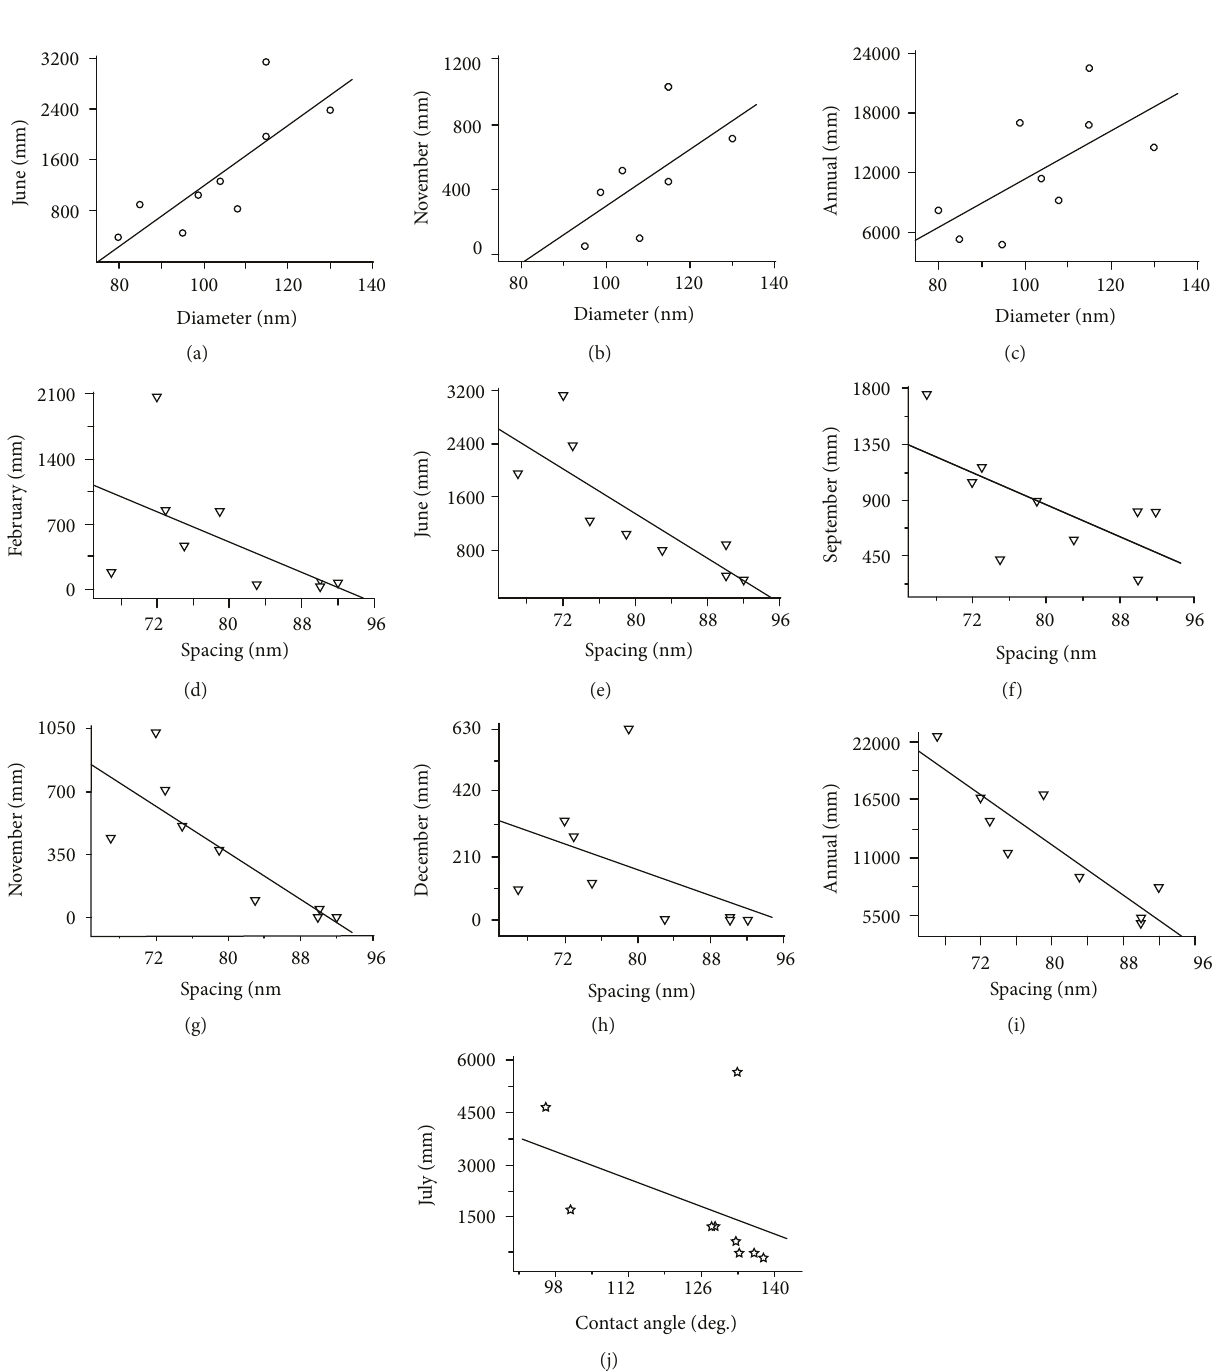
Figure 5: Correlation of protrusion diameter (a – c) with the monthly precipitation of locations and the year the samples of cicada Cryptotympana atrata were collected. (a – c) The diameter of nanostructure parameters has a signi fi cant correlation with the precipitation in June, November, and annual rainfall. (d – i) The spacing shows signi fi cant correlation with the precipitation in February, June, September, November, December, and annual rainfall. (j) The contact angle (CA) shows signi fi cant correlation with the precipitation in July. Precipitation data were collected from the China Meteorological